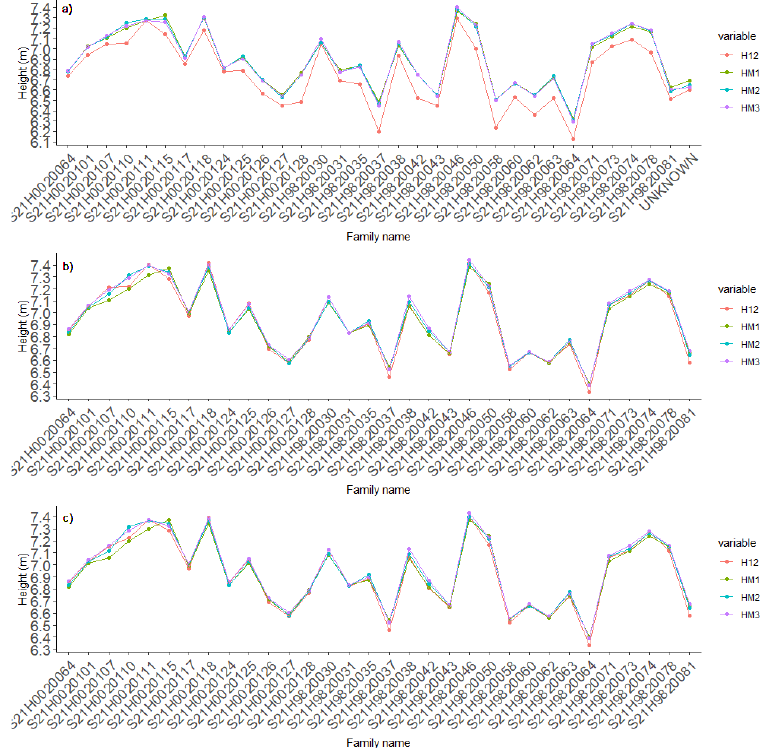
Figure 6. Average heights at 12 years of representatives of the 32 full-sib families obtained from measurements (red) and the three height models (HM1, HM2, HM3): ( a ) based on all trees, ( b ) excluding trees shorter than 3.0 m, ( c ) excluding trees shorter than 3.0 or taller than 10.0 m. There were slightly weaker correlations between mean values of traits for genotypes and the estimates obtained using all three models than for the single trees (Figure 7).